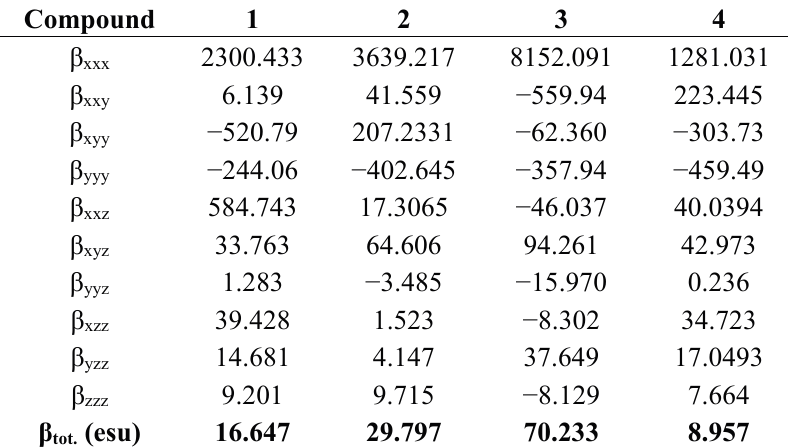
Table 11. First hyperpolarizability parameters of 1 – 4